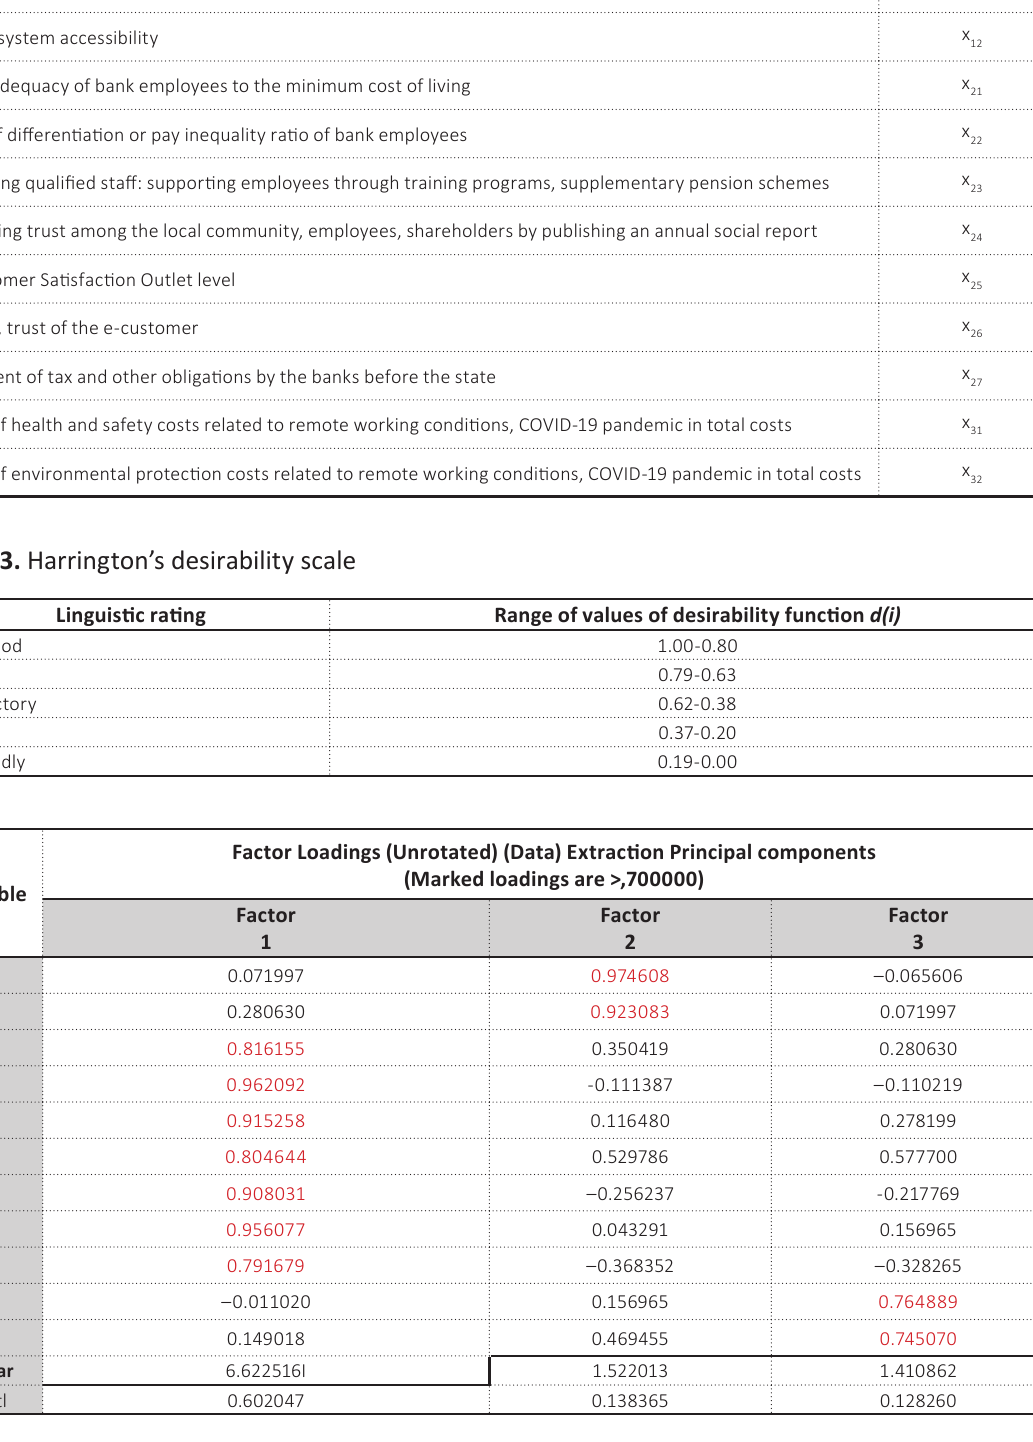
Figure 3. Listing of the factor analysis results of digitalization level